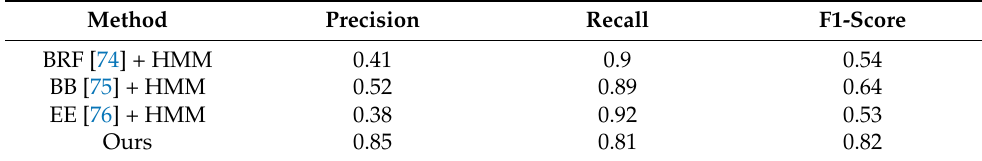
Table 4. Average precision, recall, and f1-score achieved with machine learning (ML) methods for imbalanced data. LOSO evaluation. Balanced Random Forest (BRF), EasyEnsamble (EE), Balanced Bagging (BB), Hidden Markov Model